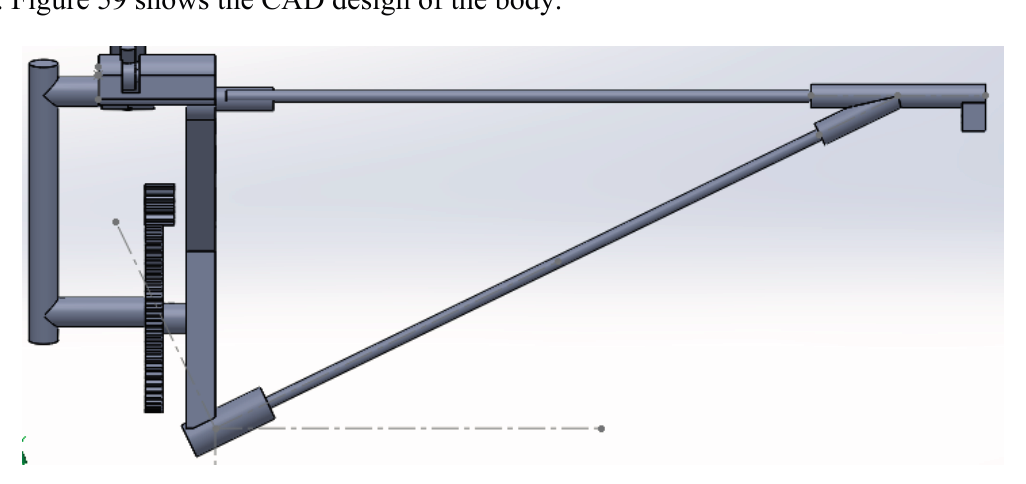
Figure 59. Prototype 2 body.